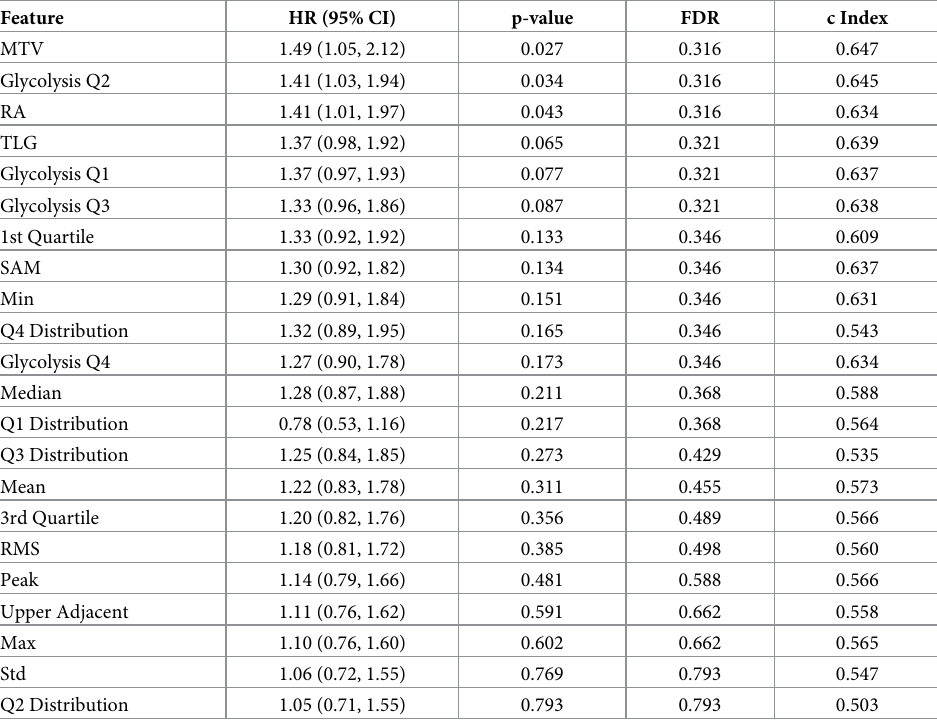
Table 3. Univariate analysis at baseline. Features are sorted by p-values.